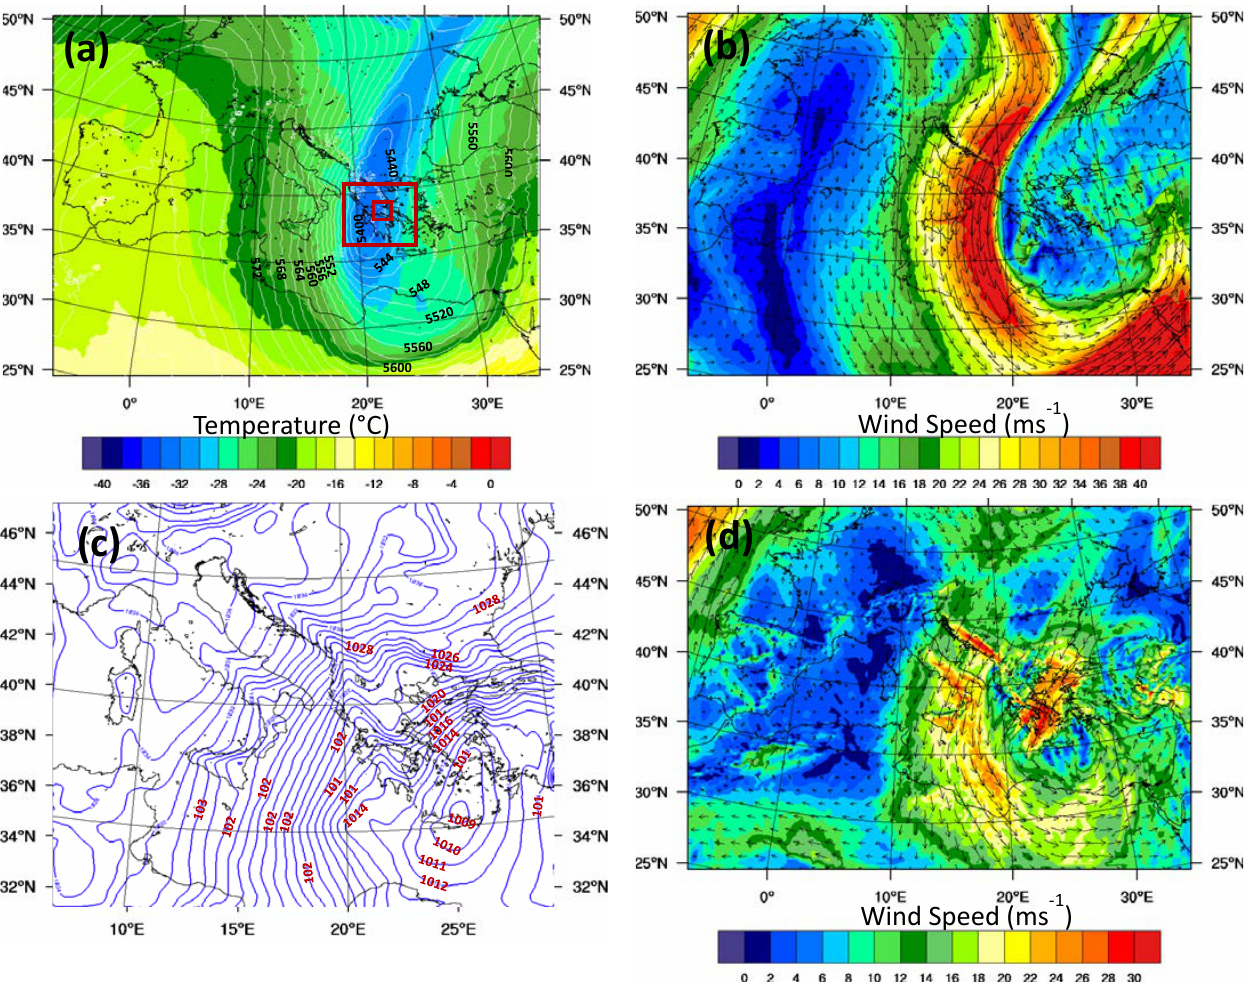
Figure 2. ( a ) Geopotential height (line contours every 20 m) and temperature (color scale in °C) at 500 mb, 13 February 2019, 18:00 UTC; ( b ) Wind speed and direction at 500 mb (m s −1 ), 14 February 2019, 00:00 UTC; ( c ) Sea level pressure (every 1 mb), 14 February 2019, 00:00 UTC (zoom from grid1) and ( d ) Wind speed and direction at 850 mb (m s −1 ), 14 February 2019, 00:00 UTC, as simulated at the external model domain. The nesting structure is also shown by the red rectangulars in Figure 2a.